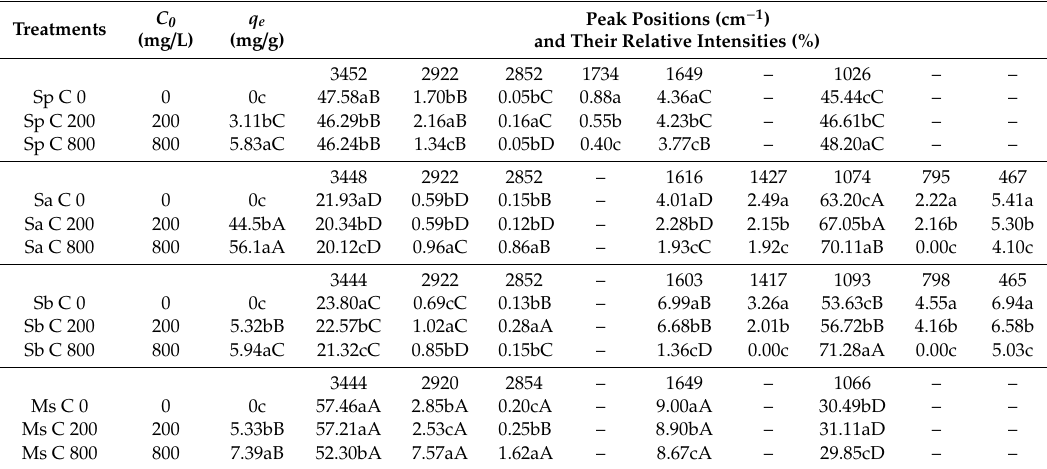
Table 3. Adsorption Capacity of Cd(II) on the Four Adsorbents from Rice Straw under Di ff erent Initial Cd(II) Concentrations and the Relative Intensities of the Absorption Peaks.